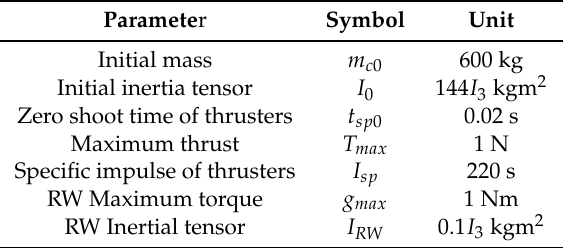
Table 1. Chaser and Thruster characteristics. RW: reaction wheel.